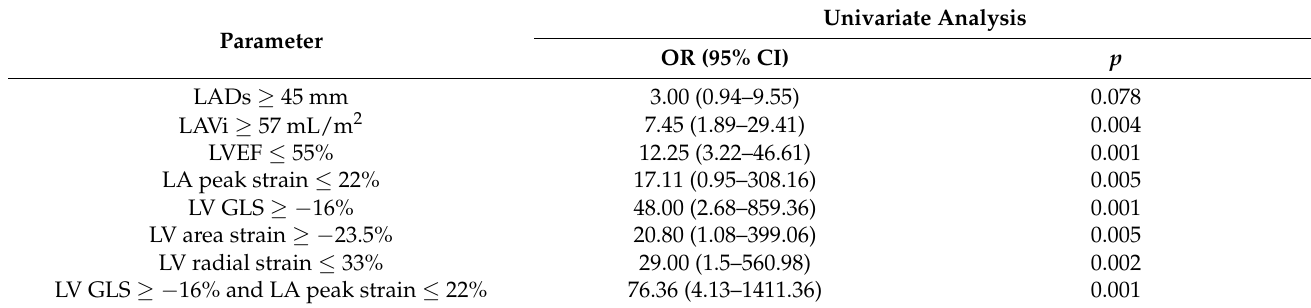
Table 4. Univariate logistic regression analysis as a predictor of the composite endpoint.